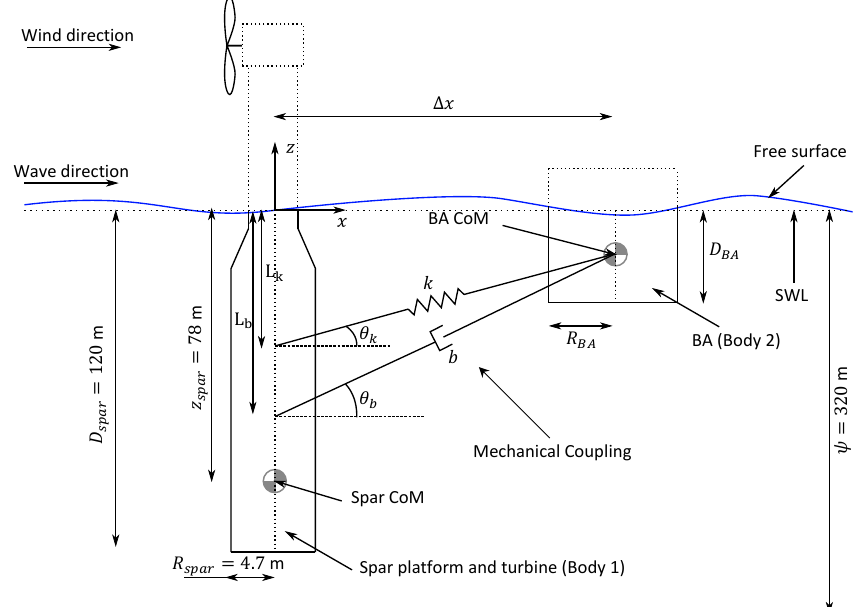
Figure 1. Representative schematic of the problem (not to